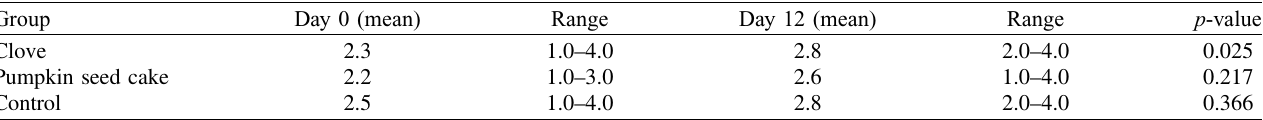
Table 3. FAMACHA score before (day 0) and after supplementation (day 12). Group